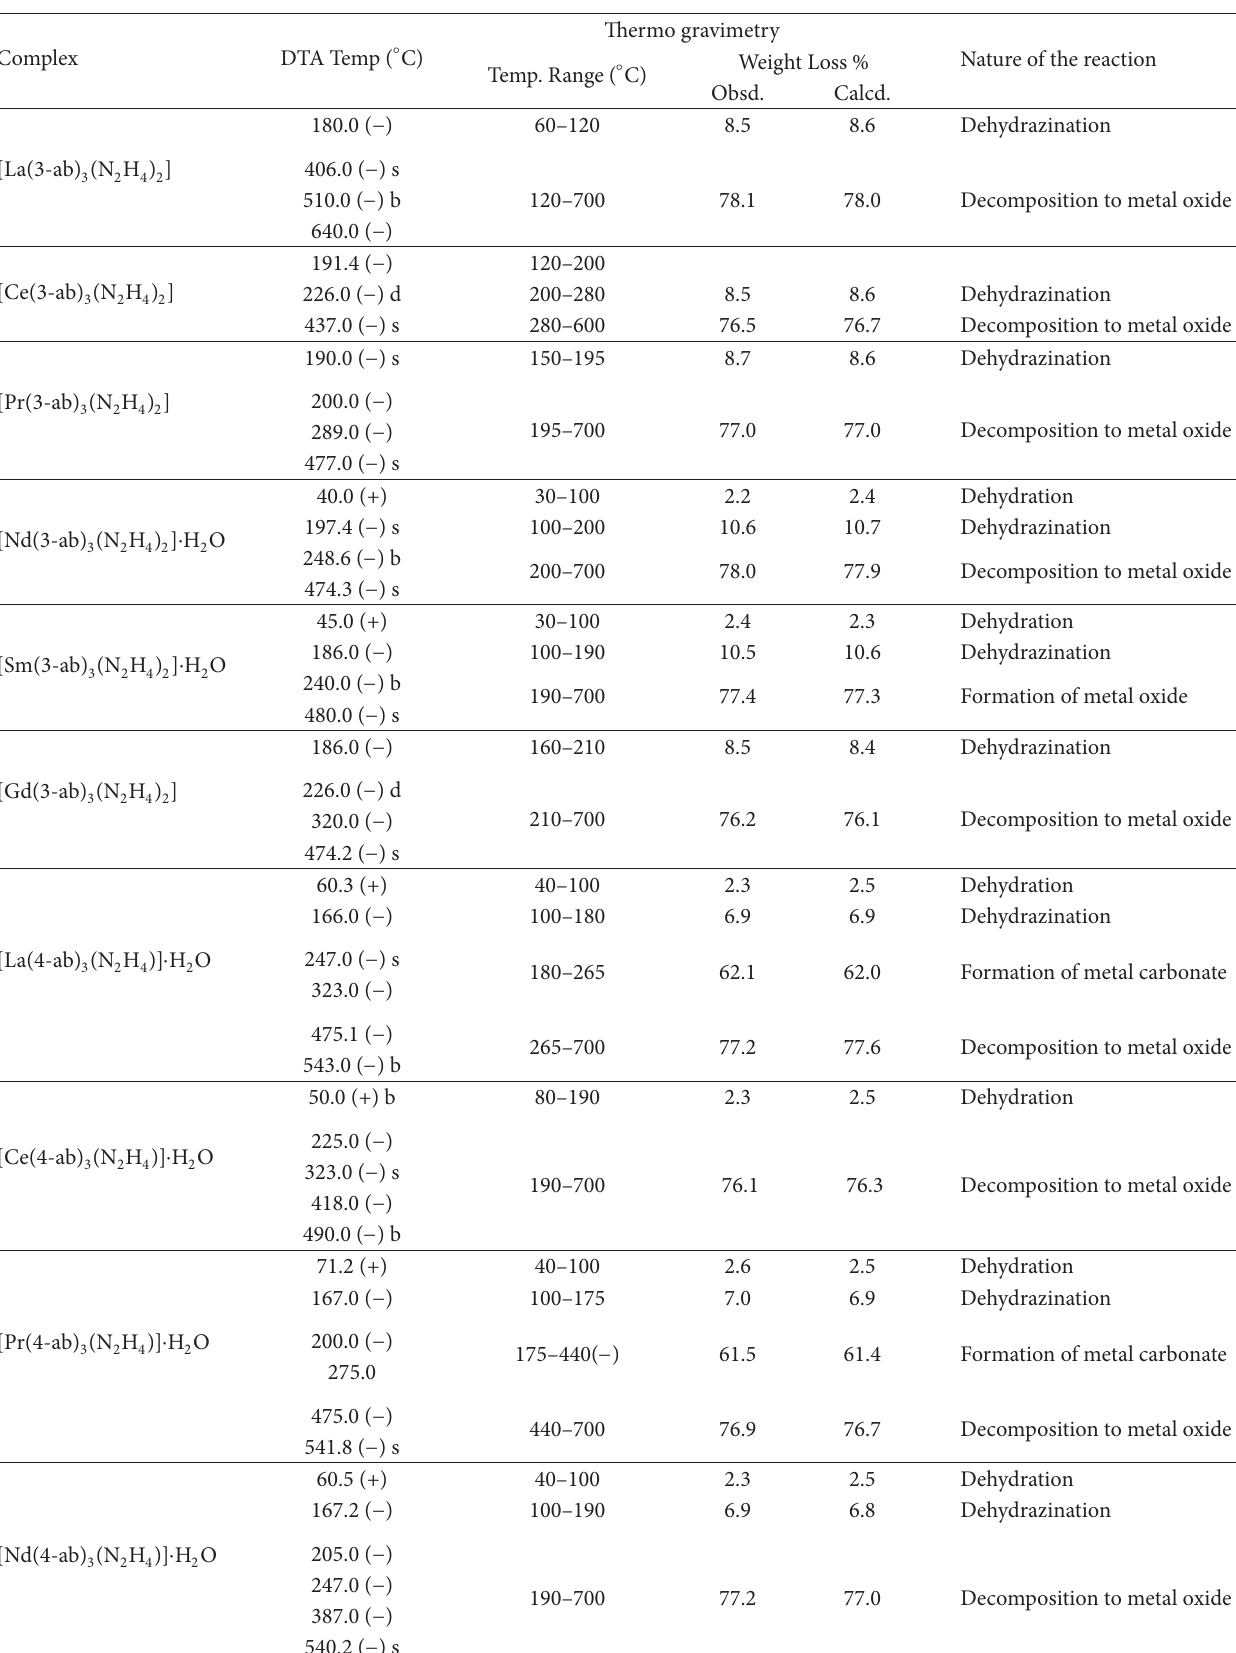
Complex DTA Temp (